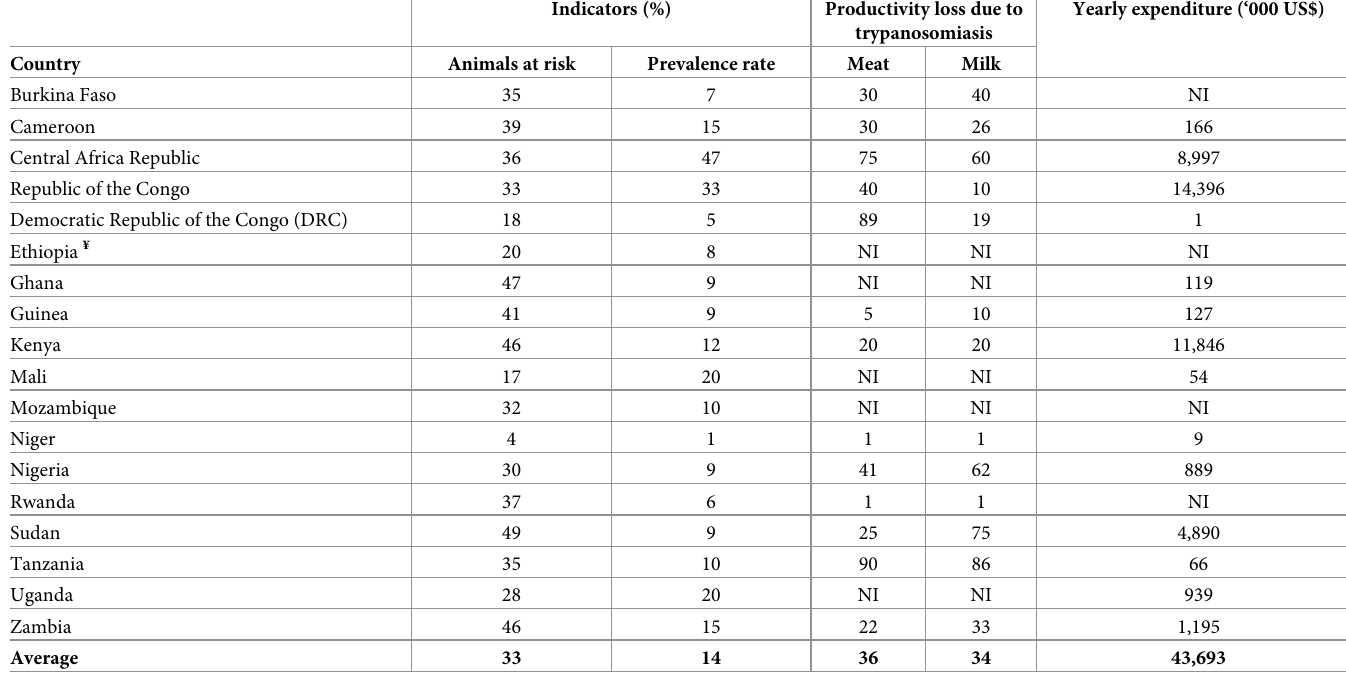
Table 2. Economic burden of Trypanosomiasis disease reported by